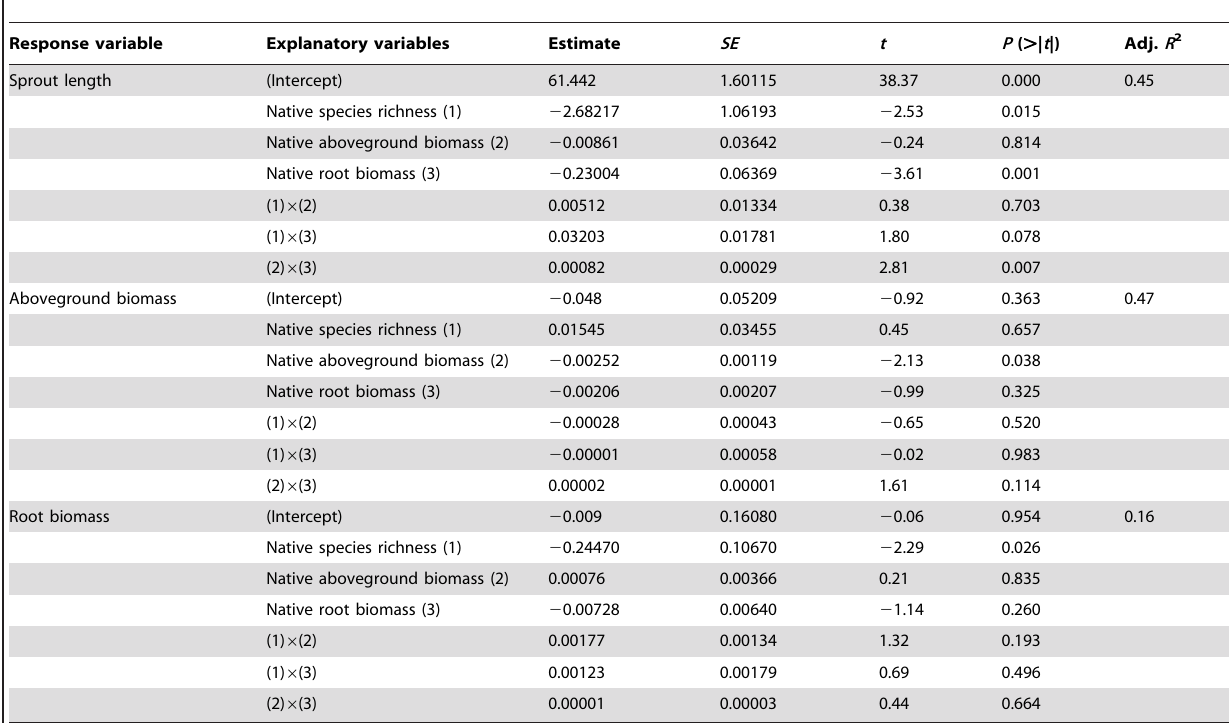
Table 1. Partial regression coefficients ( 6 standard errors) derived from multiple regression models evaluating the relationship between U. arrecta traits and three explanatory variables.